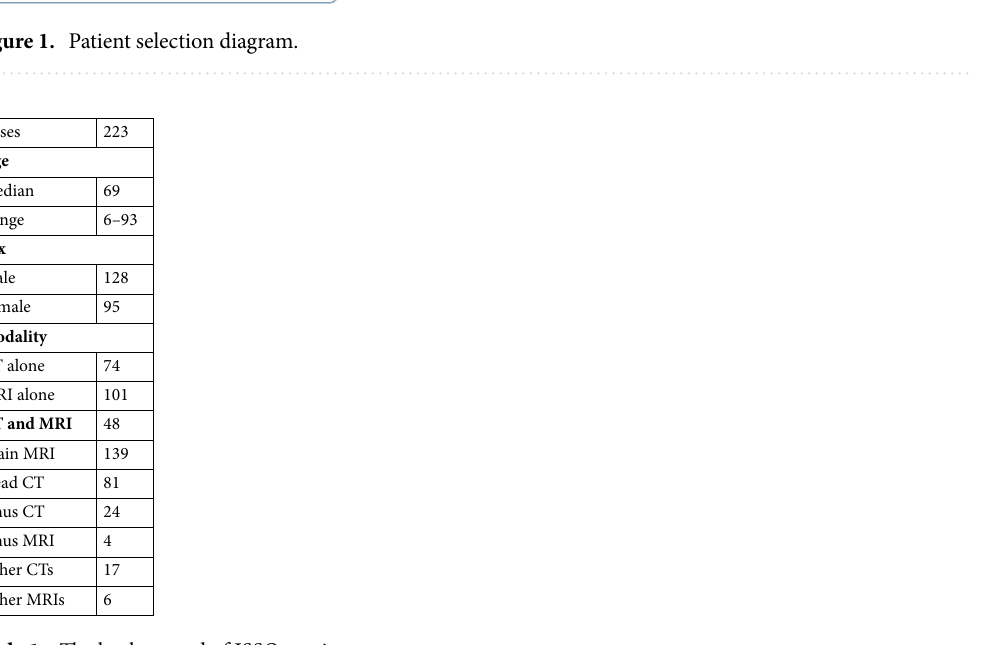
Table 1. The background of ISSOs